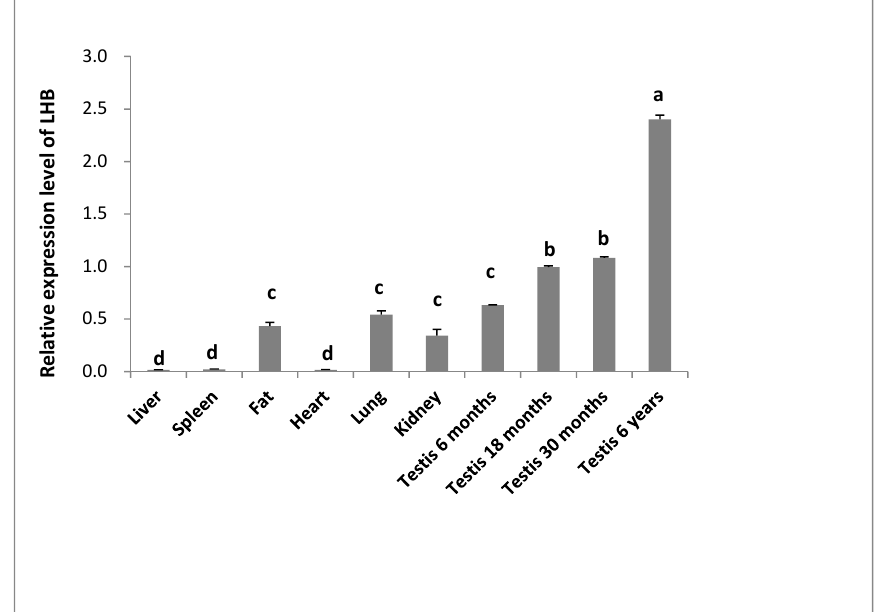
Figure 3. The relative expression of the LHB mRNA level was evaluated by quantitative real-time PCR from different tissues of Datong yak. Different letters indicate a significant difference ( p < 0.05).